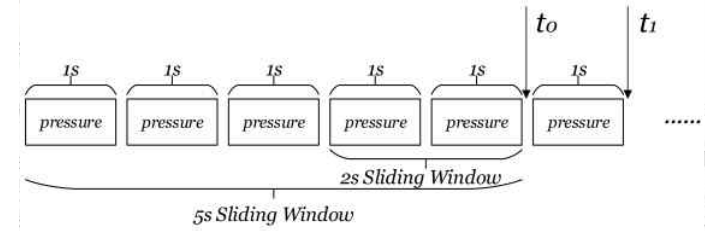
Figure 4. Double-windows pressure